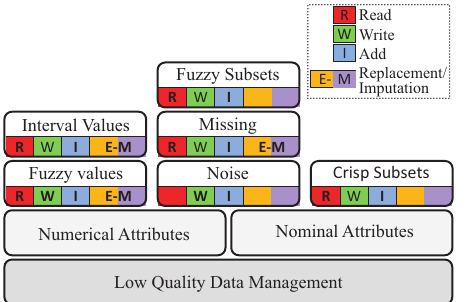
Fig. 2. Low quality data and their management by